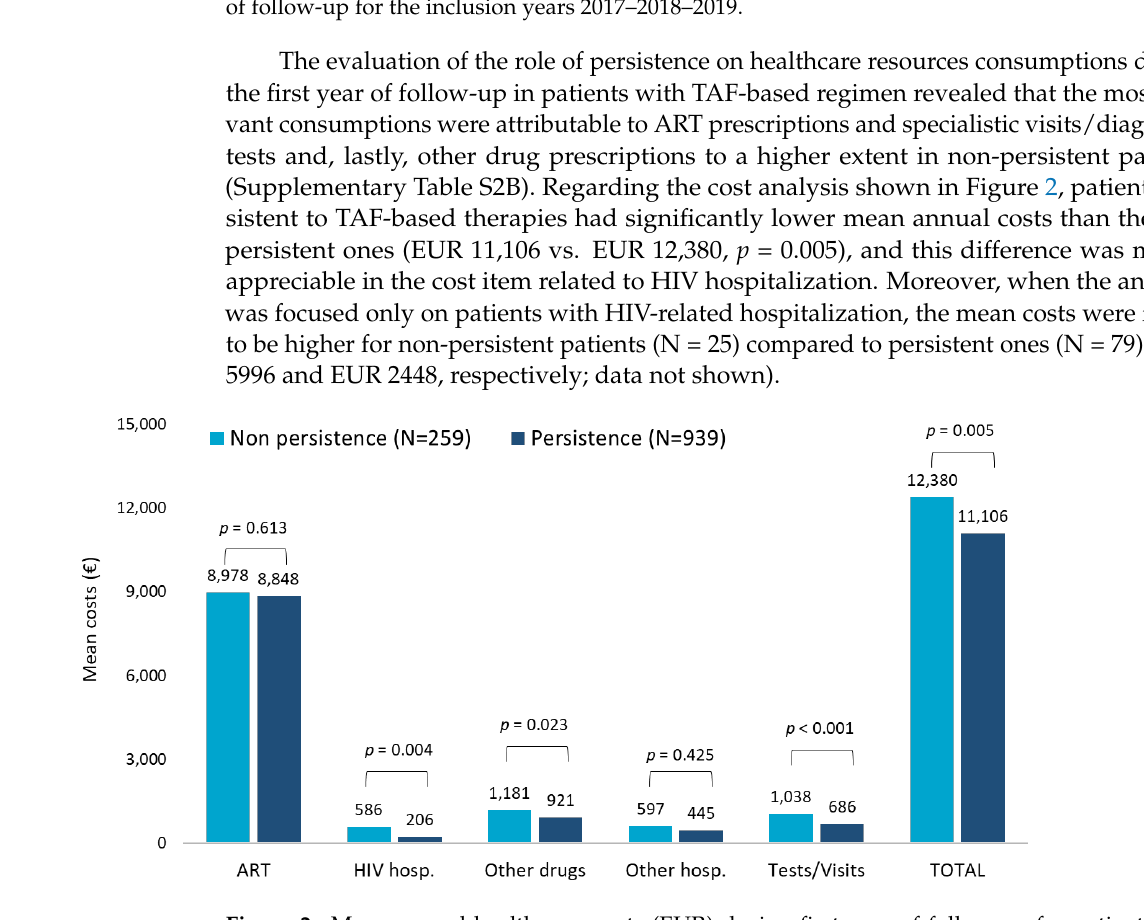
Figure 2. Mean annual health care costs (EUR) during first year of follow-up for patients with TAF-based regimen based on persistence.